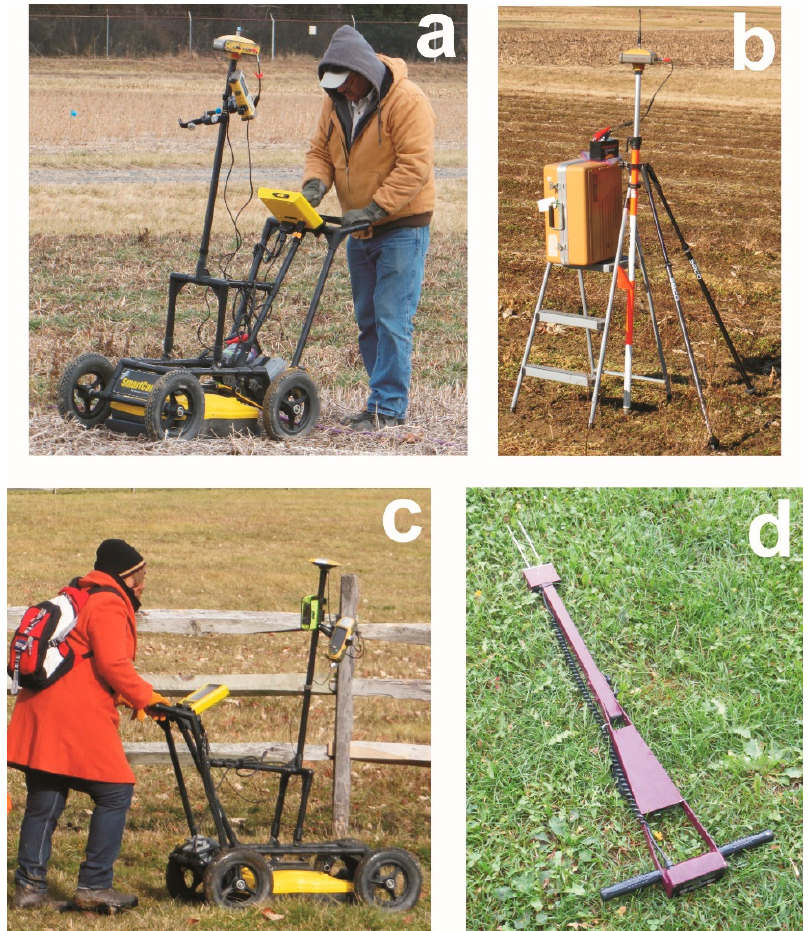
Figure 3. Equipment used in investigation: ( a ) Noggin GPR system (250 MHz antennas) with GNSS FC-200 rover receiver; ( b ) GNSS HiPer XT base station receiver; ( c ) Noggin GPR system (250 MHz antennas) with GNSS GRS-1 rover receiver and PG-S1 hand-held controller; ( d ) Field Scout TDR-300.